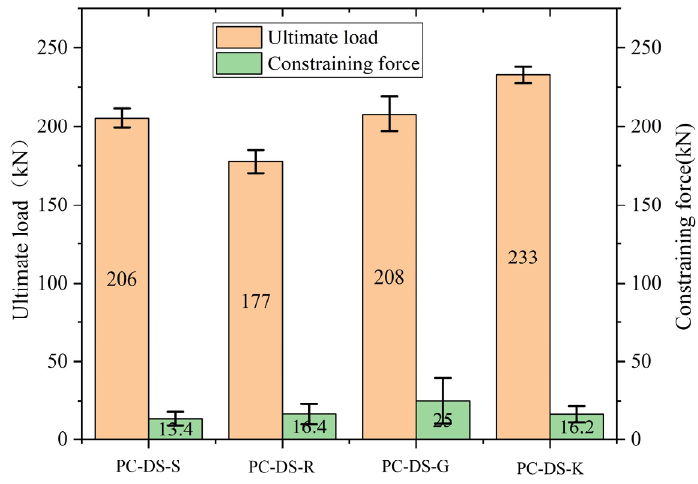
Figure 8. The change of load and passive constraint force with the increase of slip.